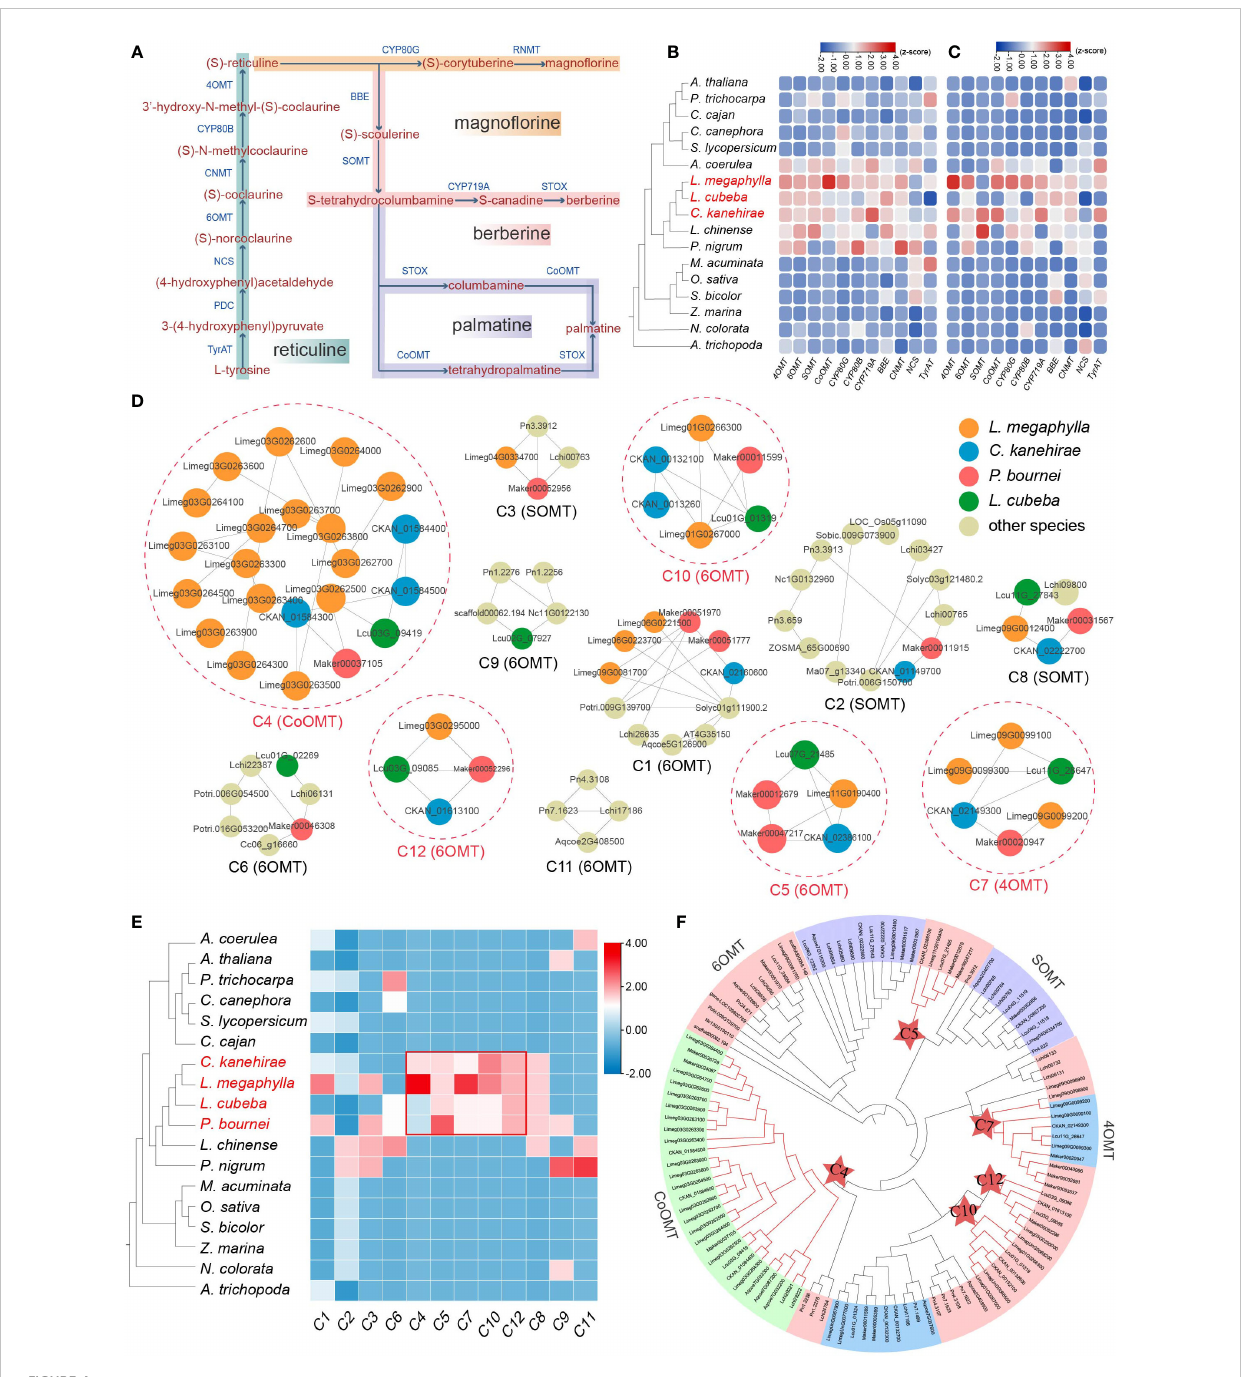
FIGURE 4 Characteristics of benzylisoquinoline alkaloid genes in Lauraceae. (A) The biosynthesis pathway of isoquinoline alkaloids. TyrAT, tyrosine aminotransferase; PDC, 4-hydroxyphenylpyruvate decarboxylase; NCS, ( S )-norcoclaurine synthase; 6OMT, (RS)-norcoclaurine 6-O- methyltransferase; CNMT, (S)-coclaurine-N-methyltransferase; CYP80B, N -methylcoclaurine 3 ′ -hydroxylase; 4OMT, 3 ′ -hydroxy-N-methyl-(S)- coclaurine 4 ′ -O-methyltransferase; CYP80G, (S)-corytuberine synthase; RNMT, reticuline N-methyltransferase; BBE, berberine bridge enzyme; SMT, (S)-scoulerine 9-O-methyltransferase; CYP719A, (S)-canadine synthase; THBO, tetrahydroberberine oxidase; CoOMT, columbamine O- methyltransferase. (B) Number of annotated genes in each enzyme gene family ( 4OMT , 6OMT , SOMT , CoOMT , CYP80G , CYP80B , CYP719A , BBE , NMT , NCS , and TyrAT ) for each species. (C) Proportion of tandem (TD) and proximal (PD) duplication genes in each enzyme gene family ( 4OMT , 6OMT , SOMT , CoOMT , CYP80G , CYP80B , CYP719A , BBE , NMT , NCS , and TyrAT ) for each species. (D) Microsyntenic gene clusters associated with subfamilies of the OMT gene family (here, 4OMT , 6OMT , and CoOMT ). Circles in dashed red line denote the syntenic clusters (here, C4, C5, C7, C10 and C12) unique to Lauraceae species. (E) Heatmap of 12 microsyntenic clusters in (D) , fi ve of which are Lauraceae- speci fi c and highlighted by a red square. The color in the heatmap represents the gene number in each cluster for each species. (F) Phylogenetic analysis of OMT gene families. The red stars represent genes within Lauraceae-speci fi c gene clusters identi fi ed in (D)